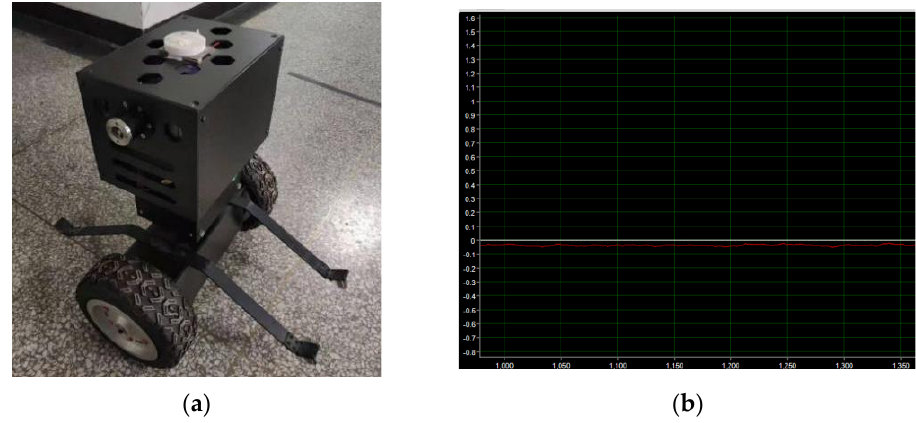
( b ) Figure 20. ( a ) Robot static experiment. ( b ) Waveform of robot at rest. 5.1.2. Posture Experiment in a Self-Balancing Stable State The self-balancing control of the two-wheel inspection robot is the precondition for the stable operation of the whole system. The inspection robot needs accurate and reliable angle information to maintain balance, which can be obtained by a gyroscope sensor. The self-balance experiment is shown in Figure 21a below. The angle deviation and angular velocity deviation are used to design the self-balancing control algorithm, which adopts proportional and differential control, that is, the traditional PD controller. After adjusting the parameters of the robot, the angular deviation ratio P parameter is set to 180, and the angular velocity differential D parameter is set to 0.78. It can be seen from Figure 21b that in the state of self-balancing control, the attitude curve fluctuates slightly up and down near the zero-degree position, and the robot maintains dynamic balance near the equilib- rium point, with a certain anti-disturbance ability. When the robot is stable, there is a small static difference between the attitude curve and the zero-degree position. There are two main reasons for this phenomenon. The first reason is the accuracy of the algorithm. There will be errors in the measurement of the parameters of the established mathematical model, and the adjustment of the parameters of the algorithm model will also bring cor- responding errors. The second reason is that the use of low-cost gyroscope sensors, sensor